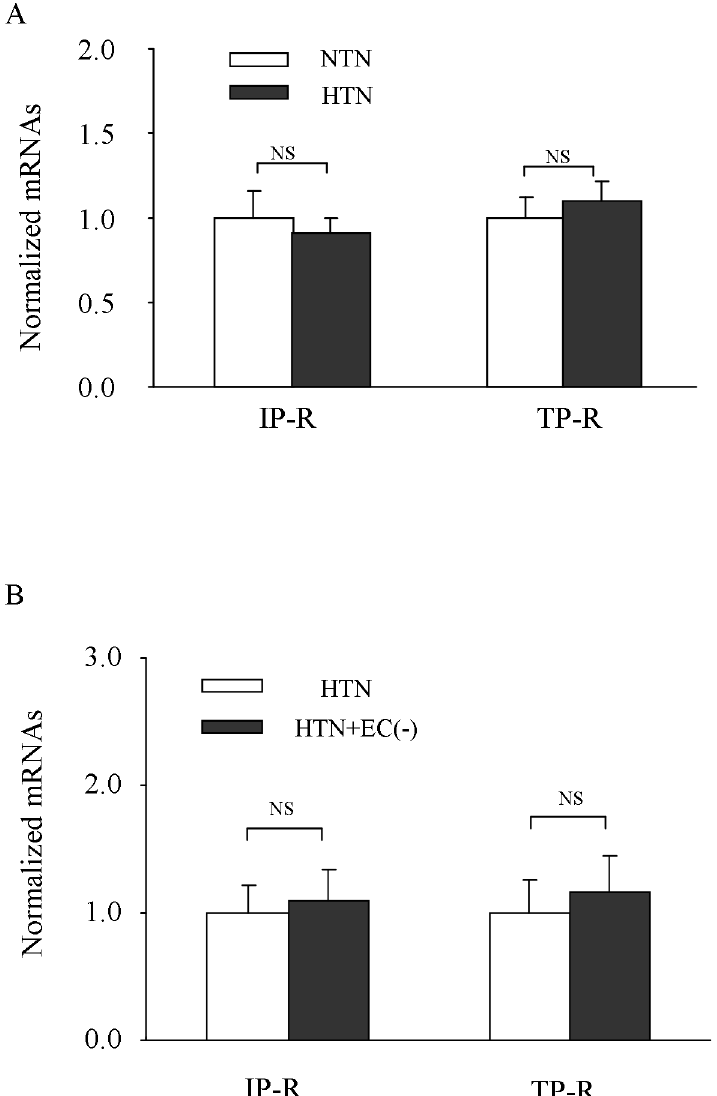
Fig 4. Expressions of IP and TP receptors in HTN carotid arteries. A : comparison of mRNA levels of IP and TP receptors detected with real-time PCR between HTN and NTN arteries (normalized to β -actin with the average value of NTN vessels assumed as 1.0; n = 6 for each). B : β -actin normalized levels of IP and TP receptor mRNAs in HTN arteries and those denuded of the endothelium [HTN + EC (-)] with the average value of control HTN vessels assumed as 1.0 (n = 3 for each). Values were expressed as mean ± SEM; NS, not